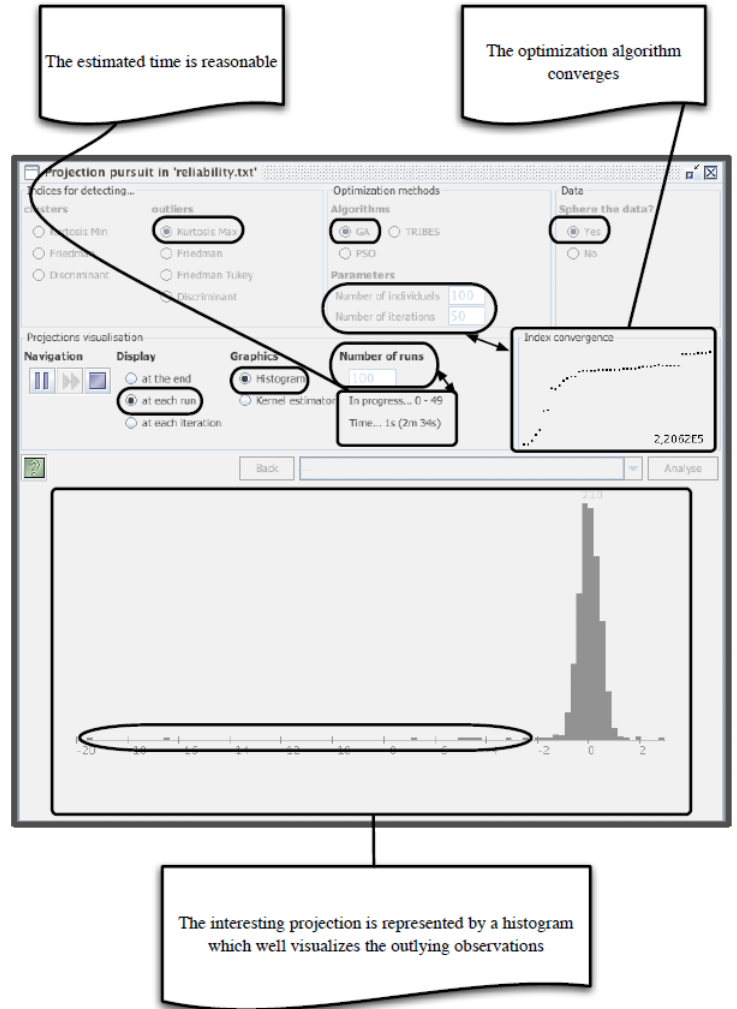
Figure 4. Outlier detection interface using EPP-Lab